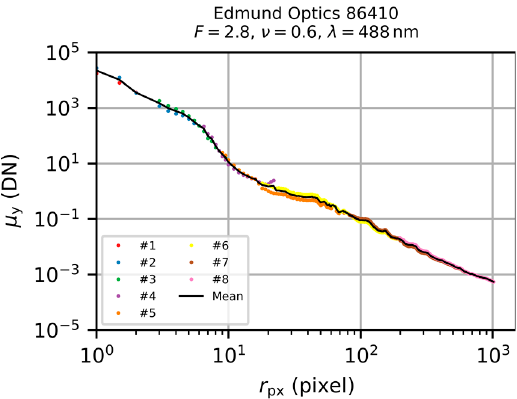
Figure 12. Scaled radial irradiance profile section of Figure 11b by taking into account the differently set parameters of the camera’s exposure time, the optical density of attenuator A2 and the laser power during image acquisition.